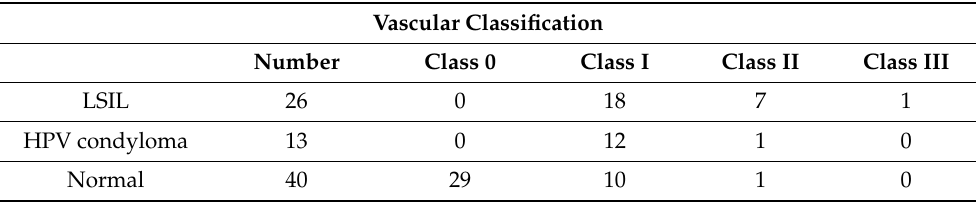
Table 1. The characteristics of the case group and control group in low-grade squamous intraepithelial (LSIL) and HPV condyloma by